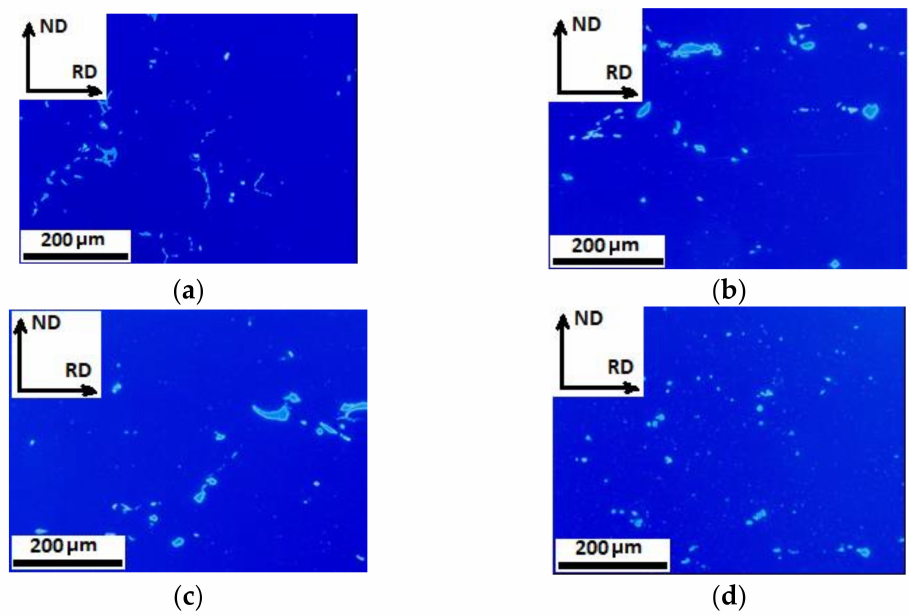
Figure 5. Micrographs of samples etched to reveal the phases of 5182 alloy: ( a ) homogenization, ( b ) 33.2% deformation, ( c ) 68.47% deformation, ( d ) 83.83%